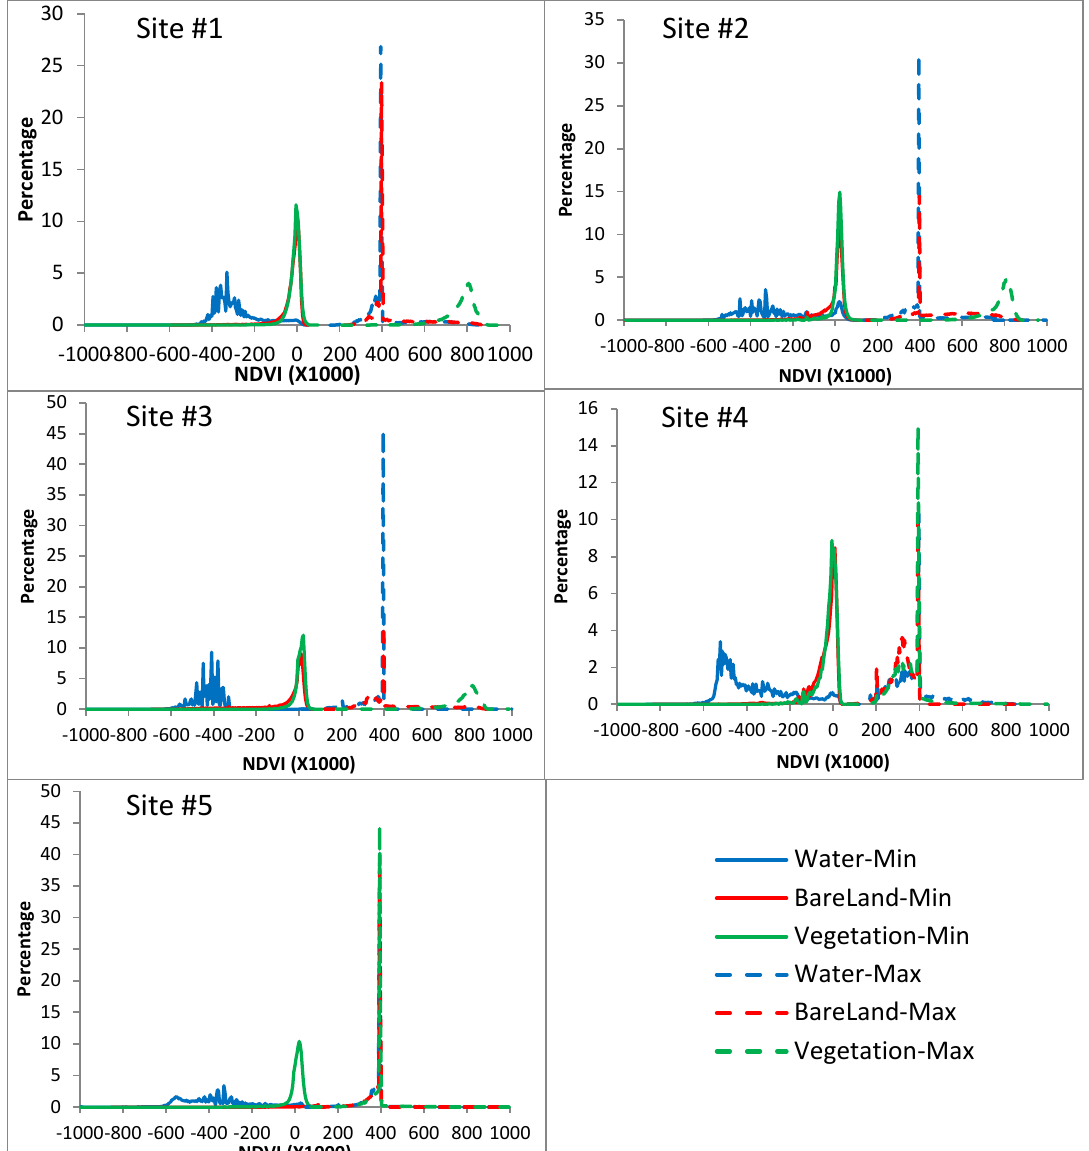
Figure 3. Distributions of maximum, minimum NDVI values within each of the water, vegetation, and bare land categories in the five testing sites. Site #1 and #2 are dominated by vegetation (crops or forests), Site #3 is dominated by water, and Site #4 and #5 are dominated by bare